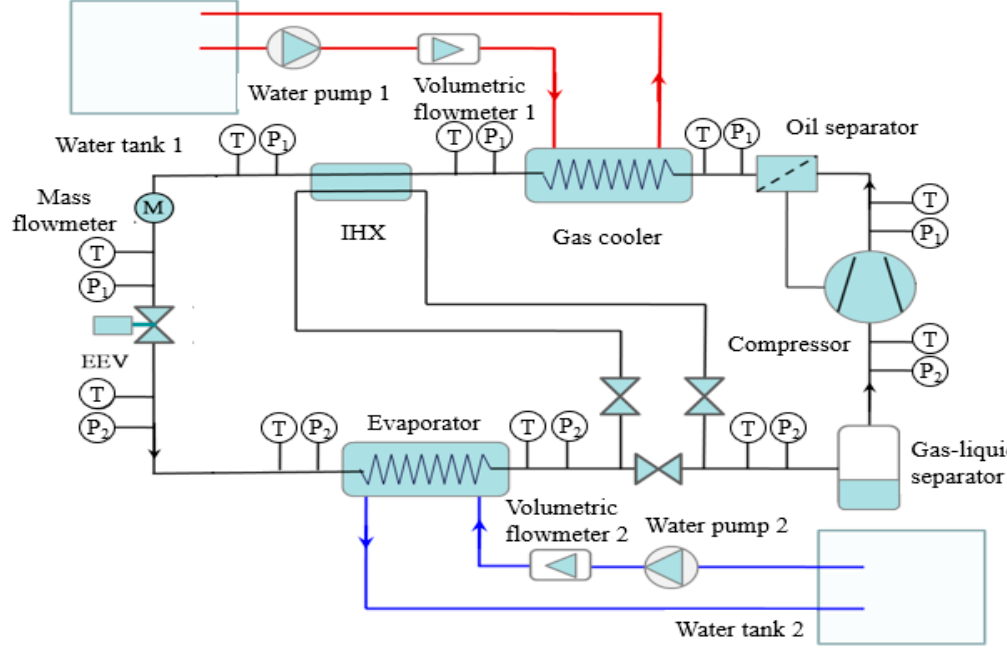
Figure 1. Schematic diagram of a transcritical CO 2 water source heat pump water heater (HPWH)